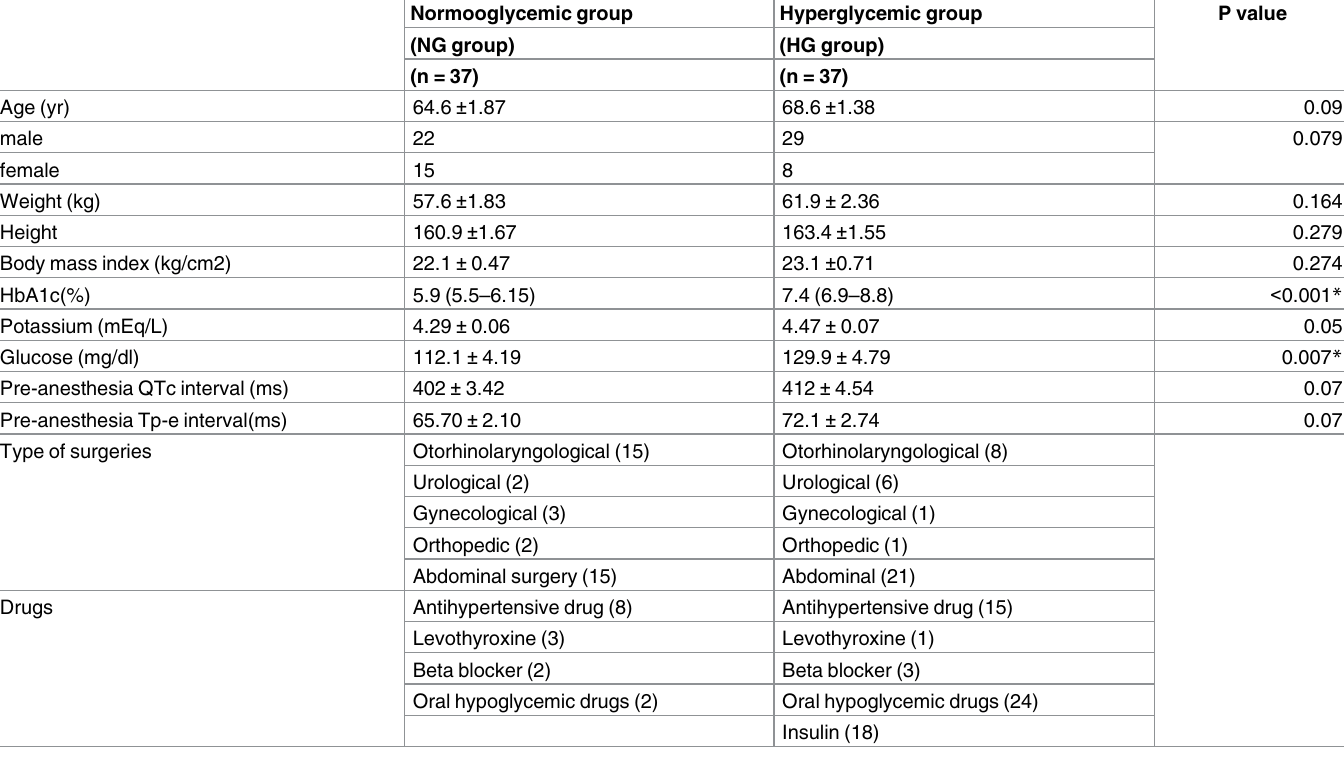
Table 1. Baseline characteristics of the study